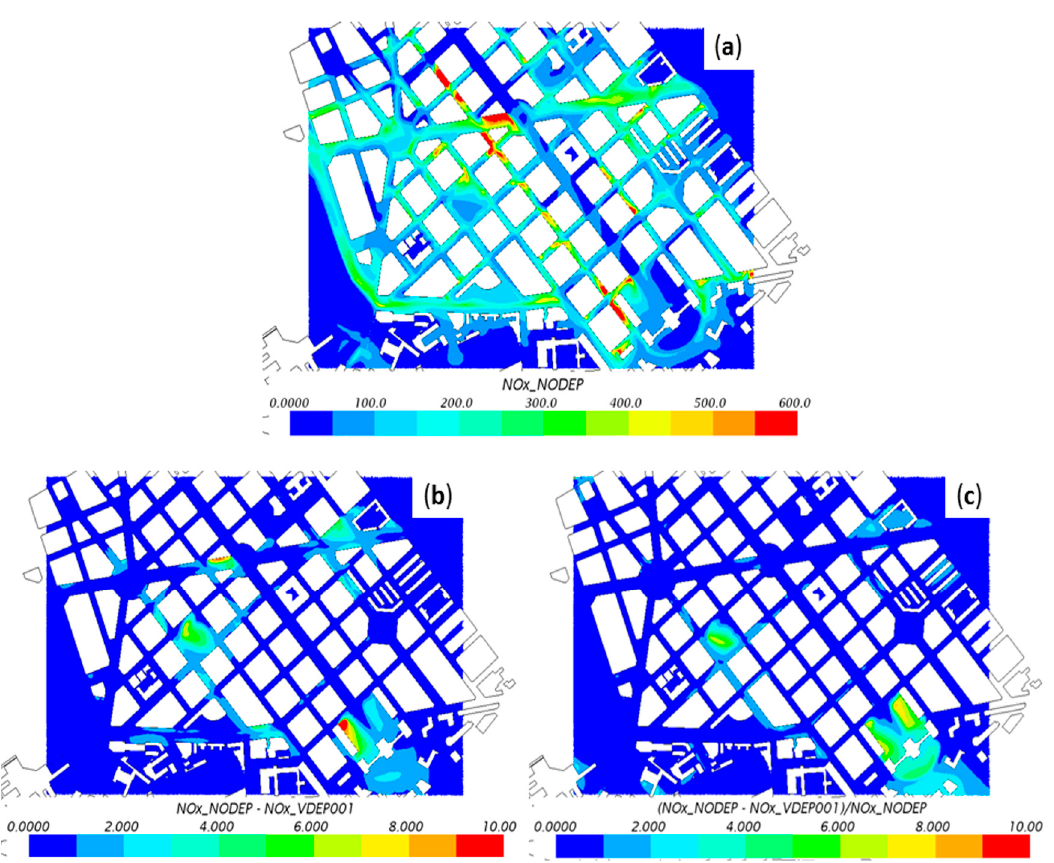
Figure 4. Current-1 scenarios: ( a ) NO x concentration map obtained by neglecting deposition; ( b ) Absolute differences of NO x concentration between considering and neglecting deposition for v dep = 0.01 m s − 1 ; ( c ) Same as ( b ), but in terms of relative percentage differences.